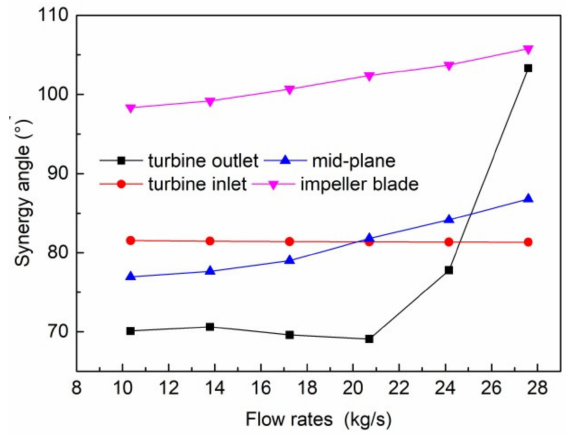
Figure 16. PAT synergy performance at various flow